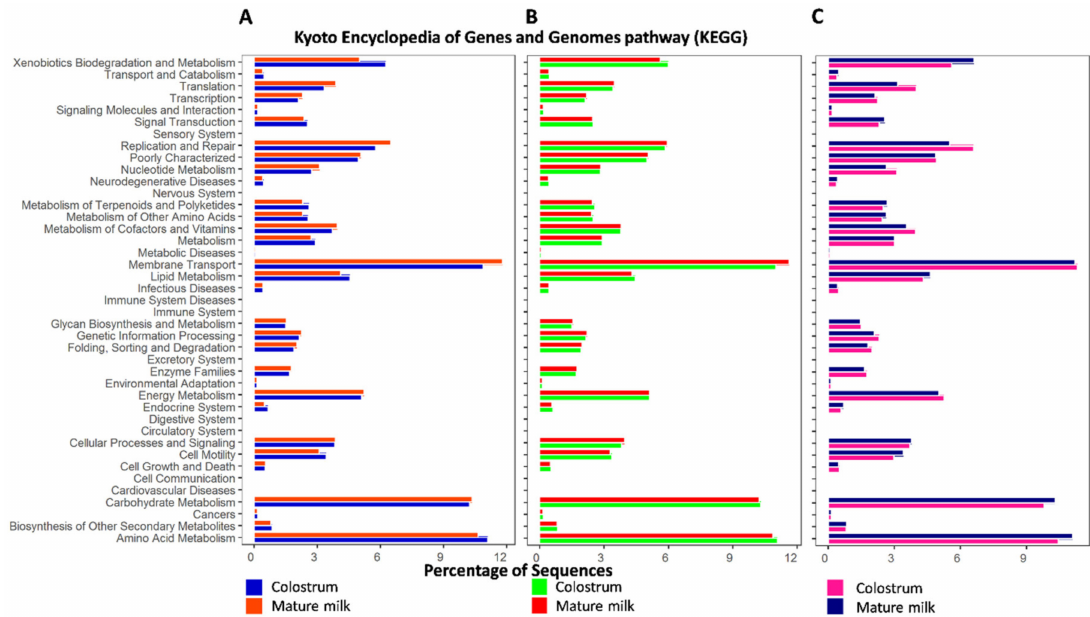
Figure 6. The main categories of the functional analysis based on the Kyoto Encyclopedia of Genes and Genomes (KEGG) pathways. Relative number of genes in microbiota from goat milk (colostrum and mature milk) from three farms ( A – C ). Signal transduction ( p = 0.03), membrane transport ( p = 0.02), transcription ( p = 0.02), and amino acid metabolism ( p = 0.03) pathways were most significantly di ff erent in farm A. Carbohydrate metabolism ( p = 0.0007) was significantly higher in farm B ( B ) goat milk